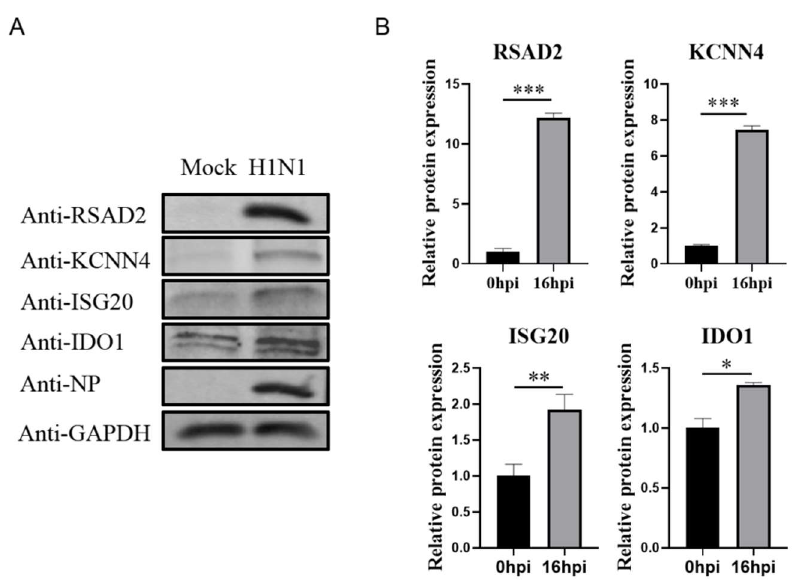
Figure 4. Verification of protein level expression of differential proteins. ( A ) The protein expression of RSAD2, IDO1, ISG20, and KCNN4 in infected MDCK H1N1 16 hpi cells was analyzed using western blot with GAPDH as the loading control. ( B ) Image software used for the gray value analysis of immunoblotting. * Was used to determine statistically significant differences between groups; * p < 0.05, ** p < 0.01, *** p < 0.001.